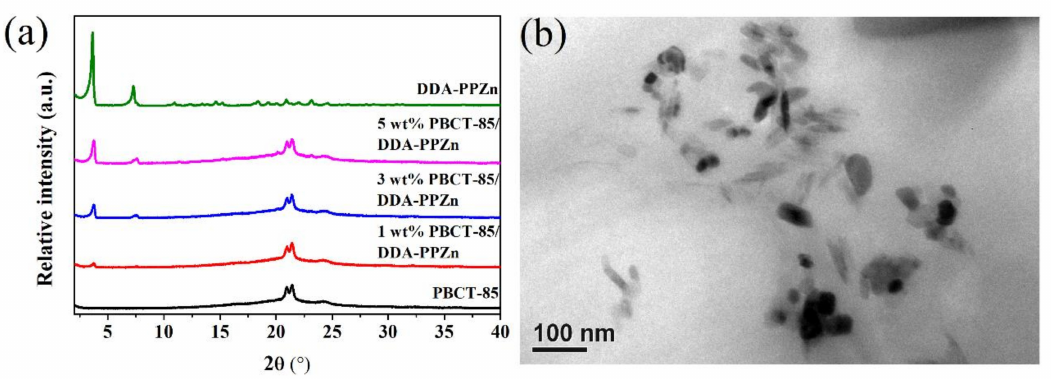
( a ) WAXD patterns of PBCT-85 and various weight ratios of PBCT-85 / DDA-PPZn